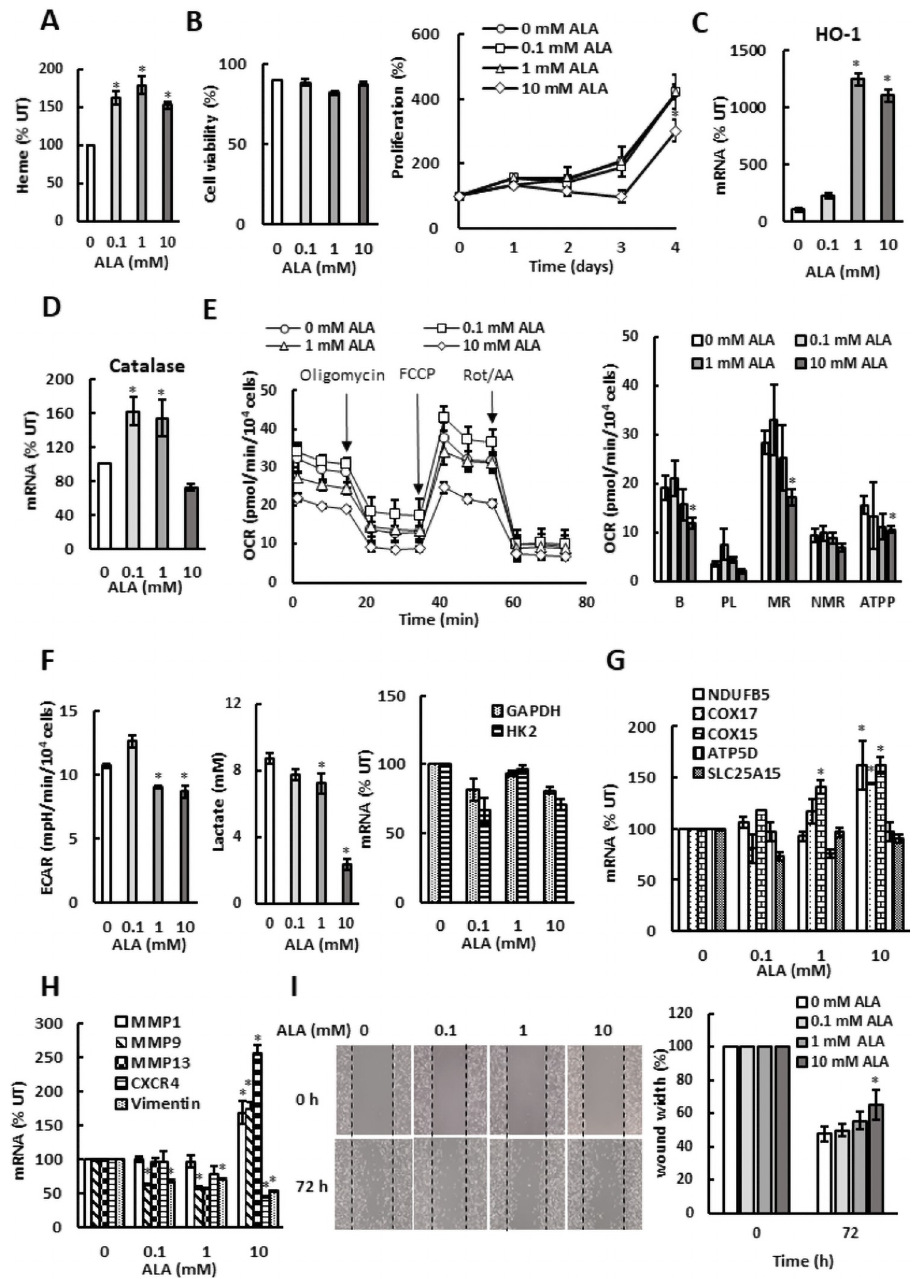
Fig 2. ALA inhibits mitochondrial respiration and aerobic glycolysis in MDA MB 231 cells. (A) Cellular heme levels and (B) cell viability and proliferation in MDA MB 231 cells treated with ALA. (C) HO-1 and (D) catalase mRNA analyzed by qRT-PCR in MDA MB 231 cells treated with ALA for 24 h. (E) OCR was measured in MDA MB 231 cells treated with ALA for 24 h. (F) ECAR, lactate accumulation in the medium, and GAPDH and HK2 mRNA levels in MDA MB 231 cells treated with ALA for 24 h. (G) Expression of ETC and OXPHOS genes in MDA MB 231 cells treated with ALA for 24 h. (H) Expression of metastatic genes in MDA MB 231 cells treated with ALA for 24 h. (I) Migration of MDA MB 231 cells treated with ALA for 72 h analyzed by wound healing assay (n = 3). (A-I) The experiments were repeated three times, and the numerical results are shown as means ± S.D. Values that are statistically different ( p < 0.05) from the control (untreated cells) are indicated by an asterisk.